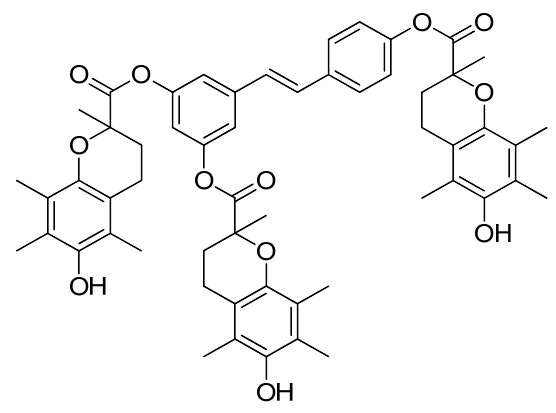
Figure 1. Resveratrol triester with trolox (RSVTR).